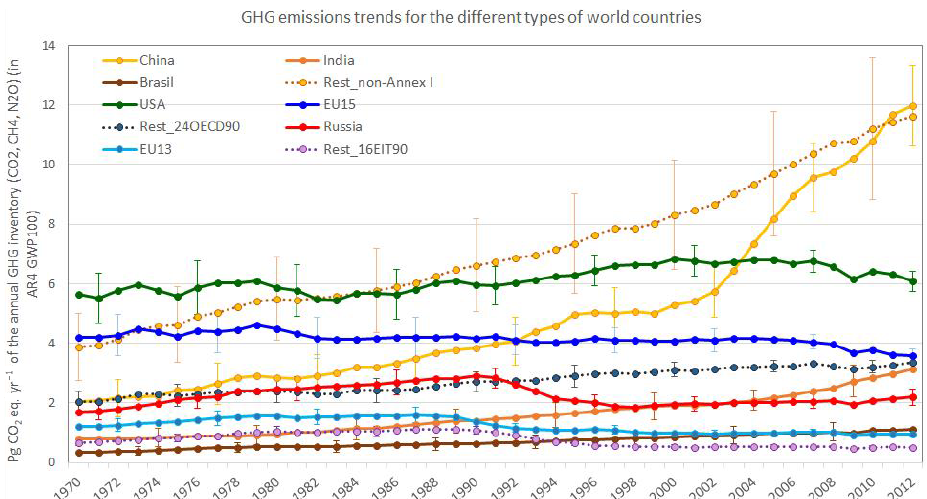
Figure 4. Annual greenhouse gas time series 1970–2012 of EDGAR v4.3.2 with periodic error bar indication for the different types of countries with top emitters: (i) non-Annex I countries with China, India, Brazil and the rest of the non-Annex I countries, (ii) 24OECD90 countries with USA, EU15 and the remaining eight OECD countries of 1990, and (iii) 16EIT90 countries with Russia, EU13 and the remaining two newly independent Eurasian states. For the figures per gas we refer the reader to Fig.